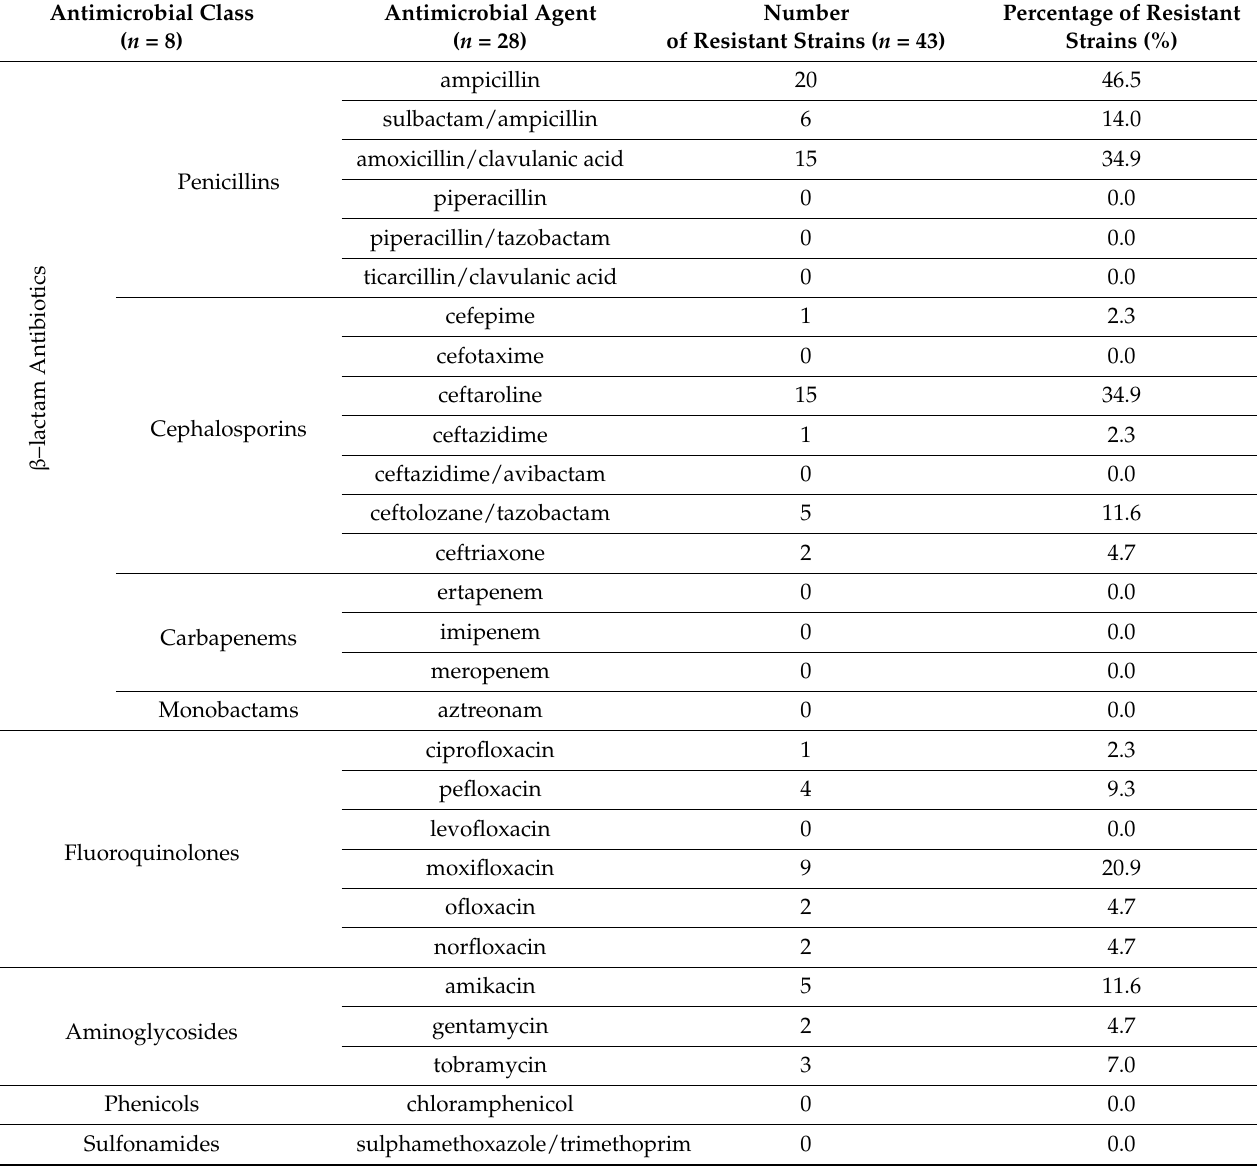
Table 4. Prevalence of phenotypic antibiotic resistance in bacterial strains. Antimicrobial